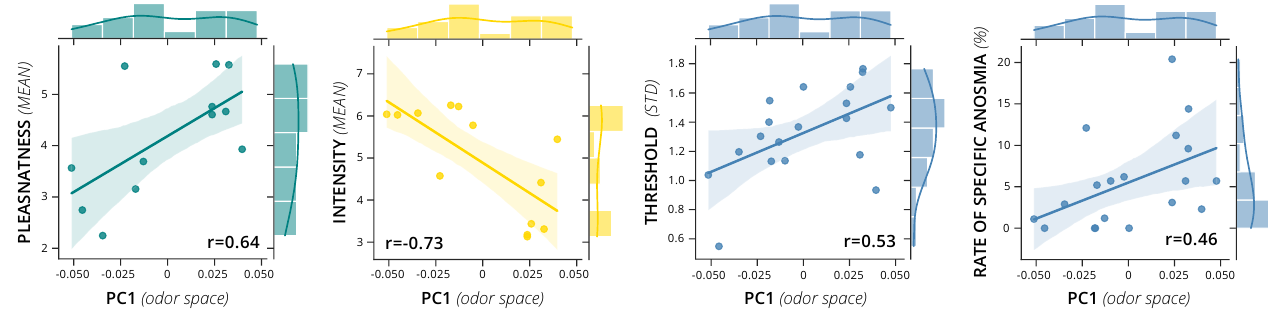
Figure 10. Associations between Physicochemical Odor Space and Perceptual Ratings. The figure shows correlations between the mean values for ( a ) pleasantness ( n = 13 odor molecules) and ( b ) intensity ratings ( n = 13), ( c ) standard deviation of detection threshold ( n = 20) as well as ( d ) the rate (%) of specific anosmia ( n = 20) with the first principal component obtained from the odor